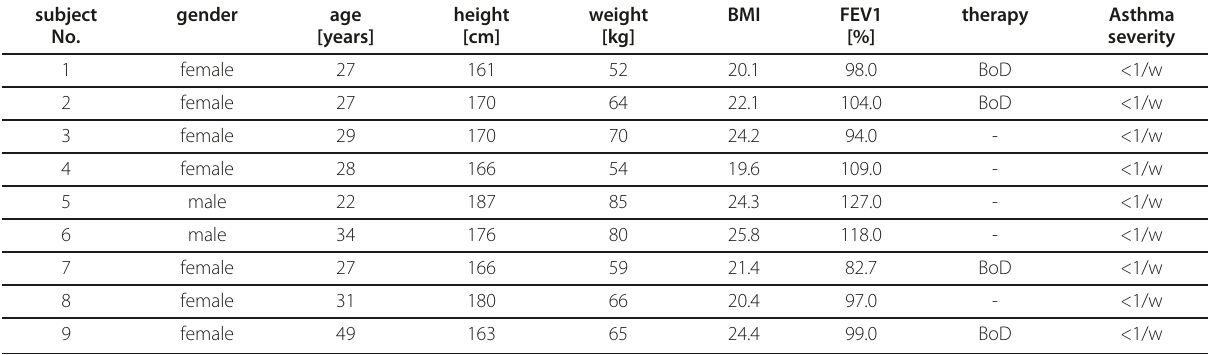
Table 1 Features of the study population